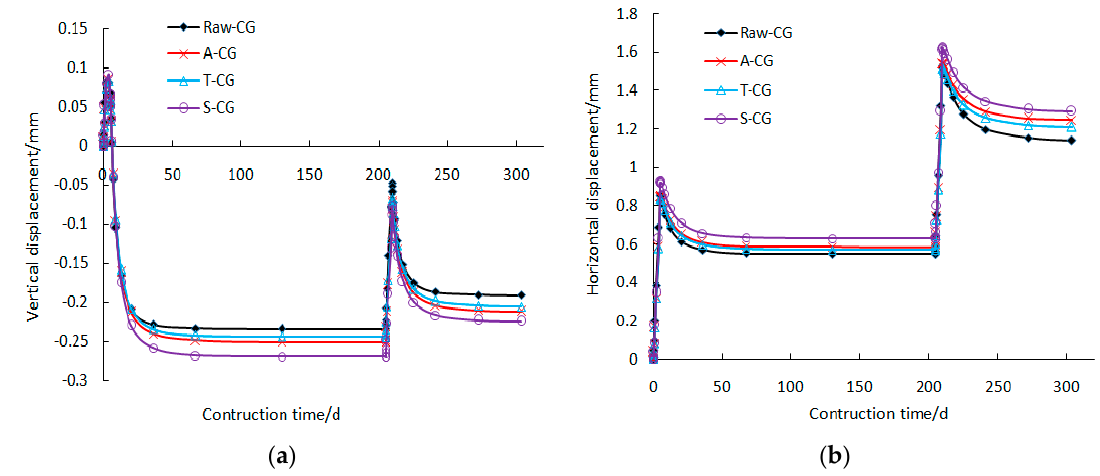
Figure 3. Curve of slope toe. ( a ) Vertical displacement, ( b ) Horizontal displacement.